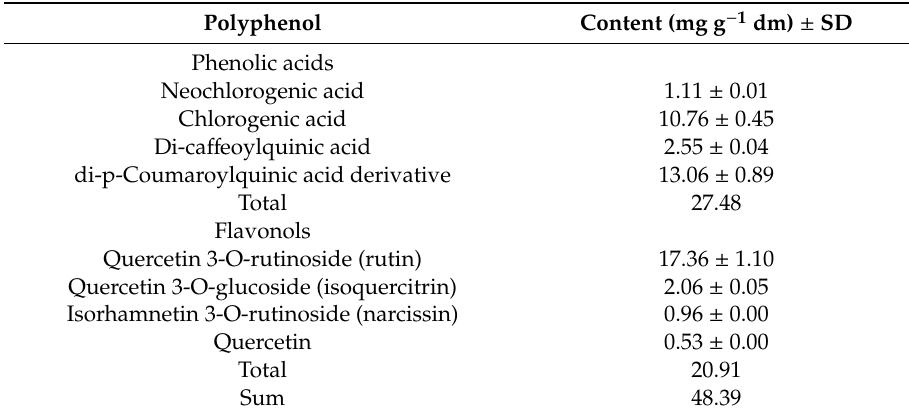
Table 5. Quantitative data for the principal polyphenols tentatively identified in the EBF extract, obtained under optimal conditions, at 80 ◦